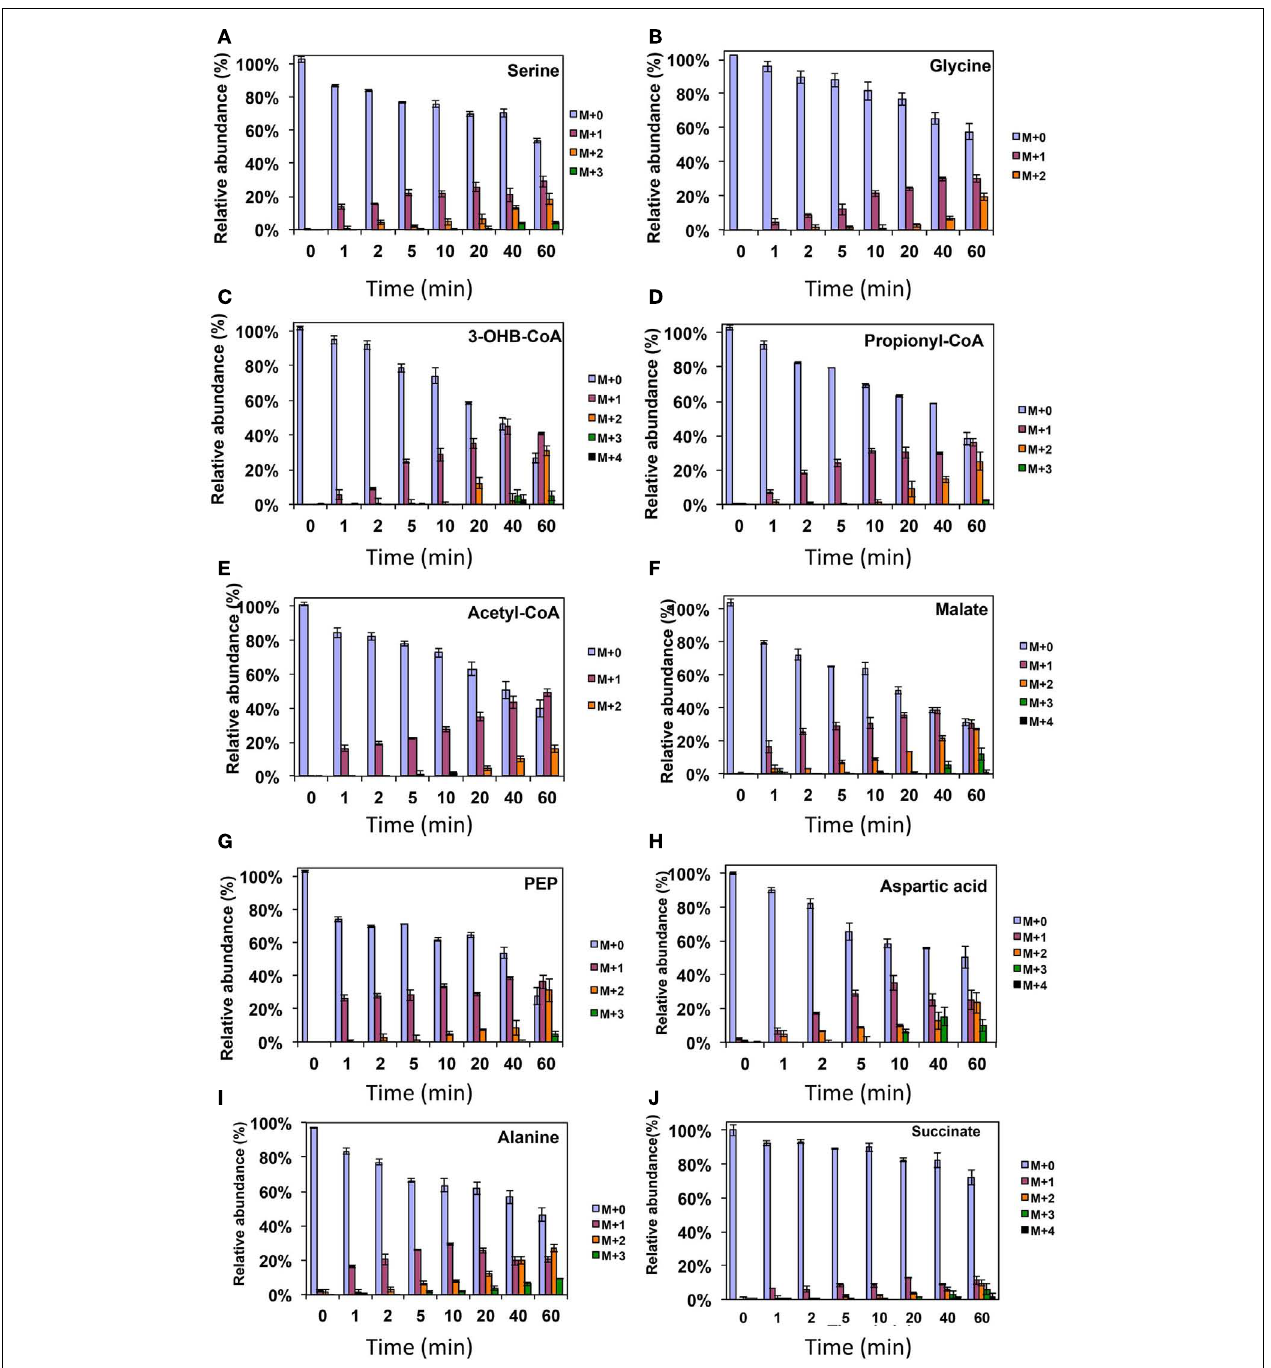
alanine (I) , and succinate (J) . Additional data are shown in FigureA1 in Appendix. M + 0 represented non-labeled compound, M + 1 represented compound with one 13 C-label, M + 2 represented compound with two 13 C-labels and so